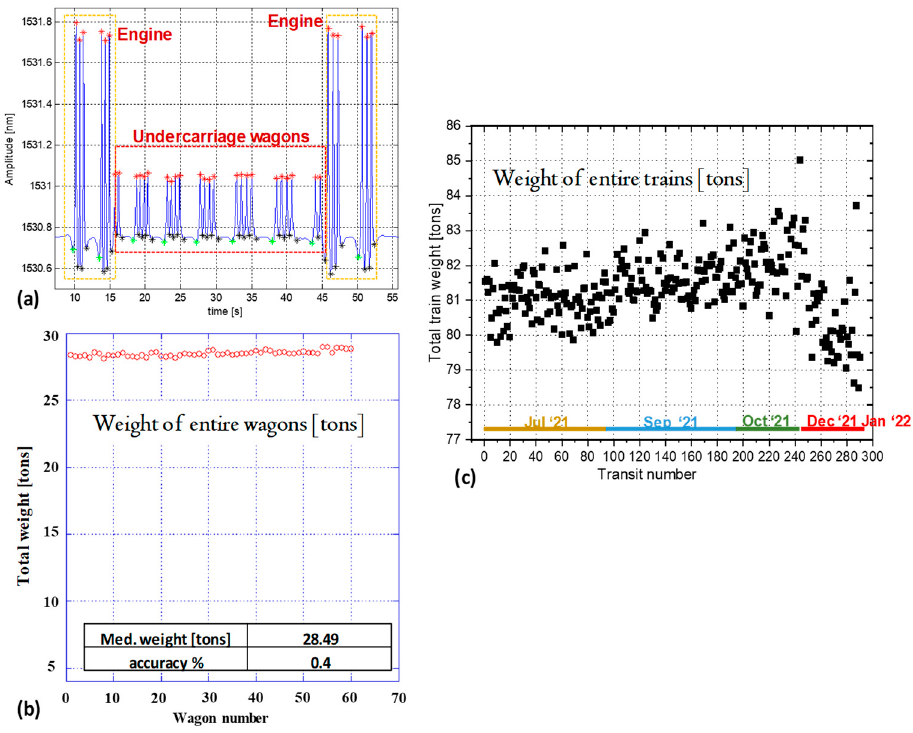
Figure 11. Typical waveform returned by a WIM–WILD sensor ( a ) and WIM results carried out by a system installed in the United Arab Emirates ( b ) and in a Milan subway ( c ). Similar results are reported in [133].